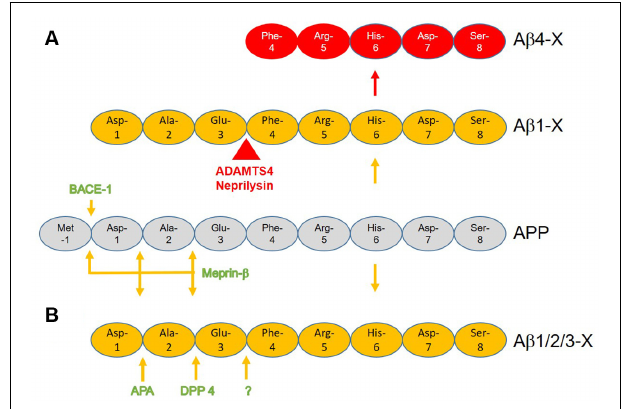
FIGURE 1 | Schematic presentation of the potential generation of N-terminal A β 4-X with known enzymatic cleavages of the amyloid precursor protein (APP) and A β 1-X . (A) β -site APP cleaving enzyme 1 (BACE-1) or meprin- β cuts APP between amino acid position -1 and +1 liberating the N-terminus of full-length A β 1-X . While ADAMTS4 further cuts between position +3 and +4 liberating A β 4–40 / 42 , the normal function of neprilysin is to detoxify A β as it has several N-terminal activities within A β with N-truncation of A β 4-X being only one alternative. (B) Hypothetical pathway(s) by which N-truncated A β 4-x is generated by sequential cleavage by meprin- β , aminopeptidase A (APA), and/or dipeptidyl peptidase 4 (DPP